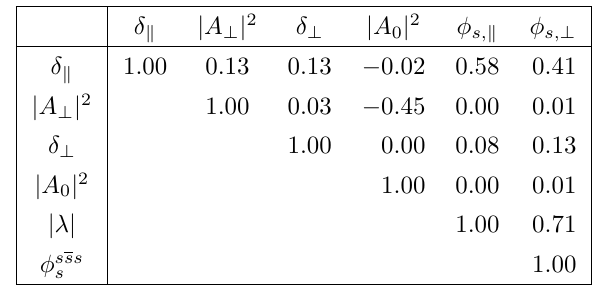
Table 9 . Statistical correlation matrix of the time-dependent (cid:12)t in which CP violation is polarisa- tion